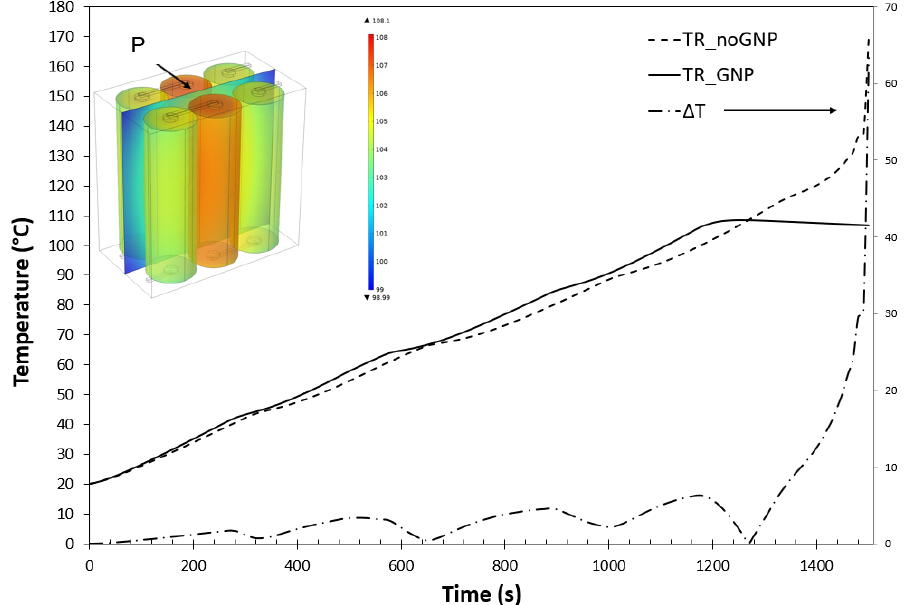
Figure 17. Maximum temperature curve vs. time, for the case with and without the heat spreader.